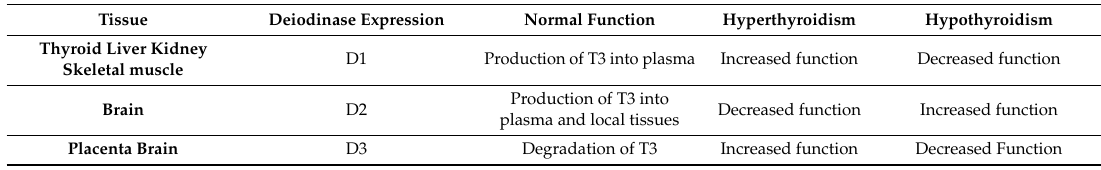
Table 1. Deiodinase expression in human tissue and its role in normal tissue function as well as in hyper- and hypothyroid states.